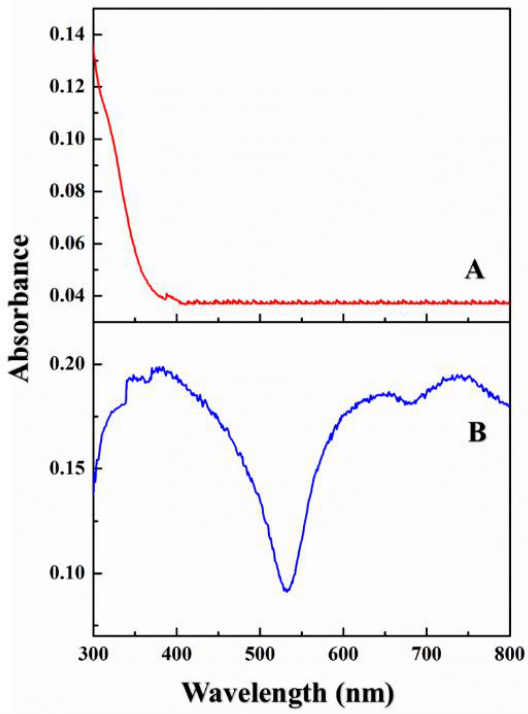
Figure 2. UV-vis spectra of CUR in water ( A ) and CUR-PC in water ( B ).